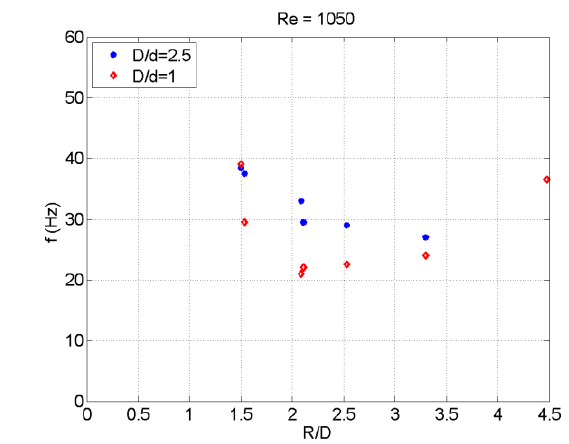
Figure 6. Relationship between the frequency and the pitch distance for Re 1050